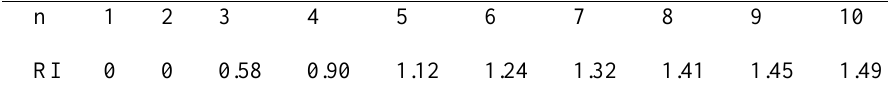
Table 4. Consistency Index, RI , of random matrices.